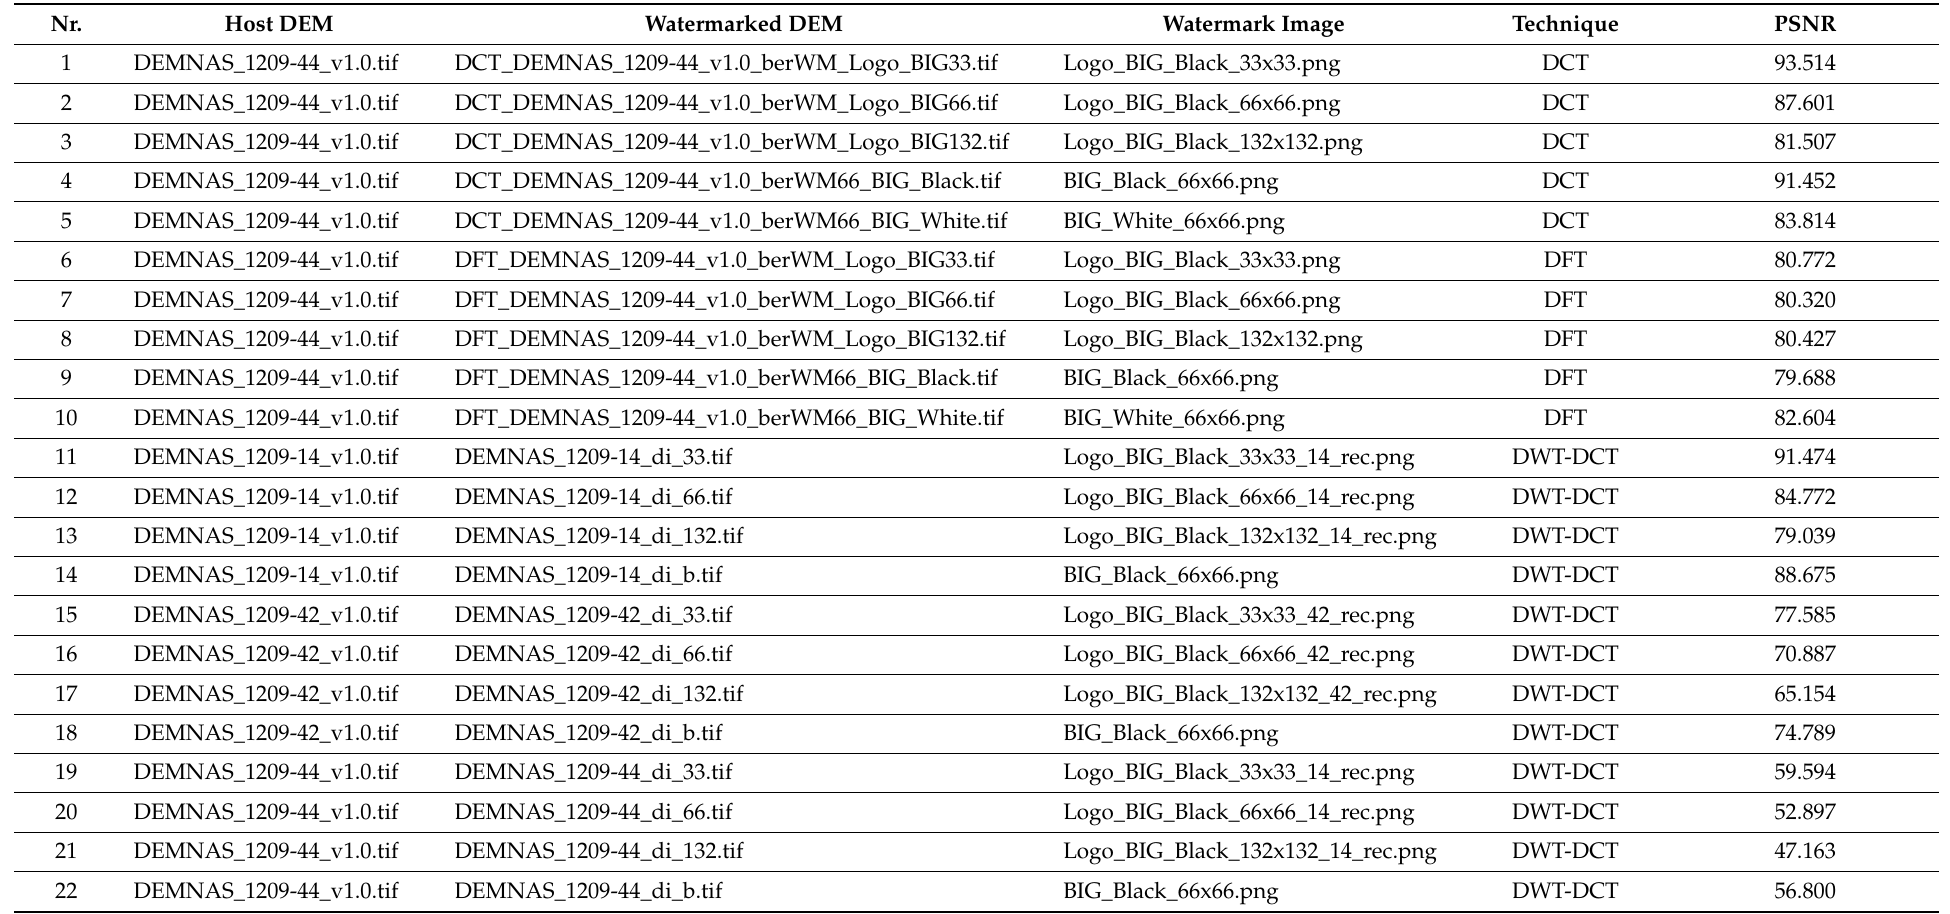
Table 9. Experimental results of the evaluation parameter of